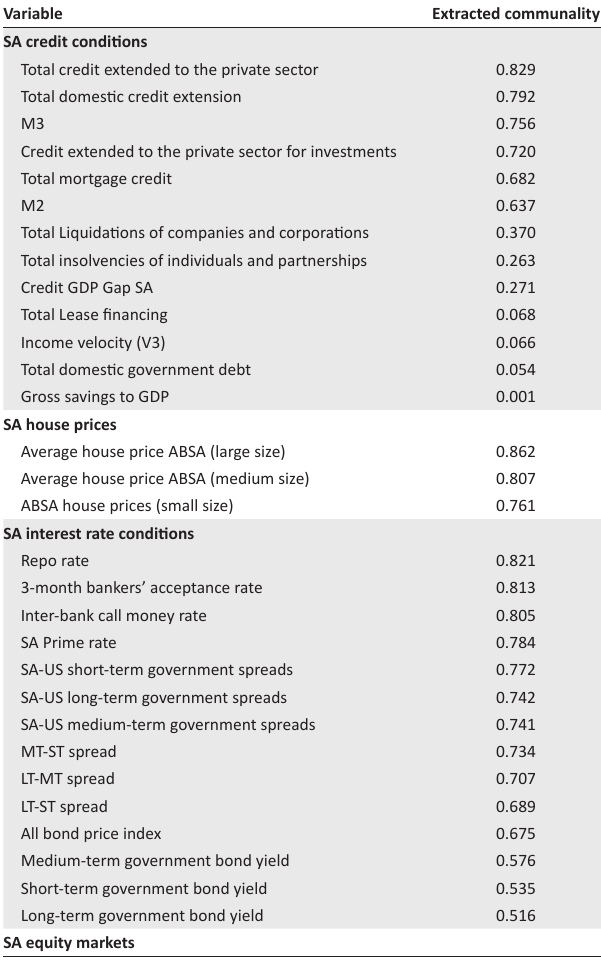
TABLE 2-A1: Extracted